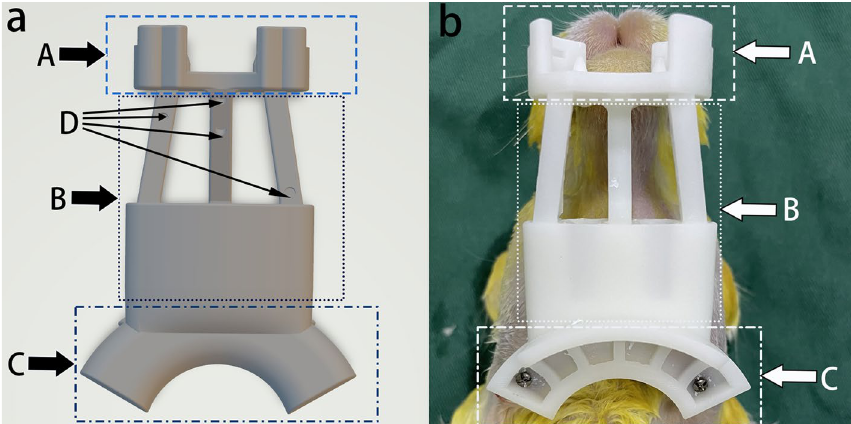
Figure 2. Registration complex. ( a ) The design schematic of the registration complex (view from the dorsal angle). ( b ) 3D-printed registration complex fixed on the rabbit mandible (view from the ventral angle). (A) fixation module, (B) connected module, (C) pedestal for the electromagnetic sensor, (D) positions to install steel balls.